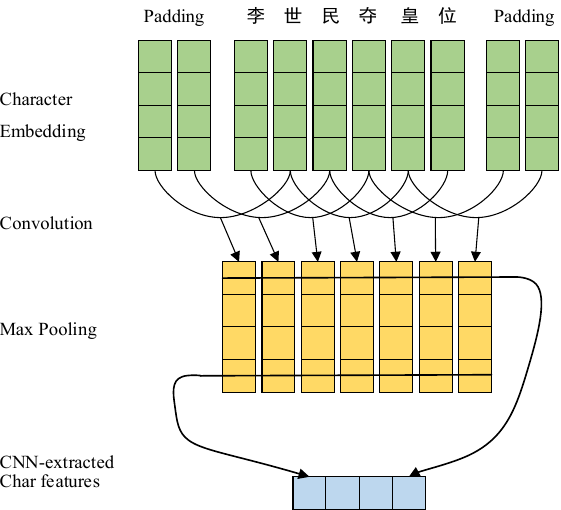
Figure 7. The convolution neural network for extracting character-level representations of words. Filled arrows indicate a dropout layer applied before character embeddings are input to CNN. The Chinese input is “ 李世民夺皇位 ” (means: Li Shimin seizes the throne), where Li Shimin is a person’s name.